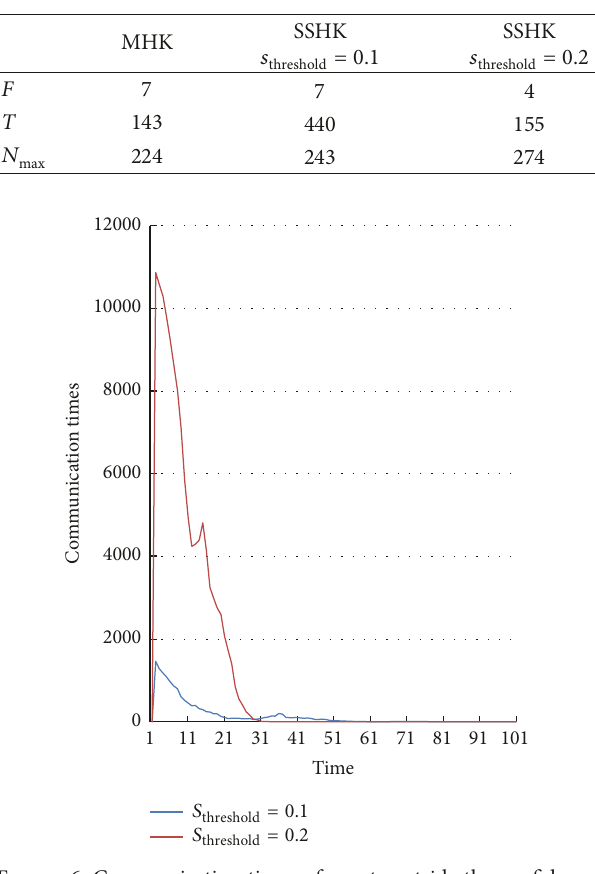
= 0.1 and 𝑠 = 0.2 . threshold threshold